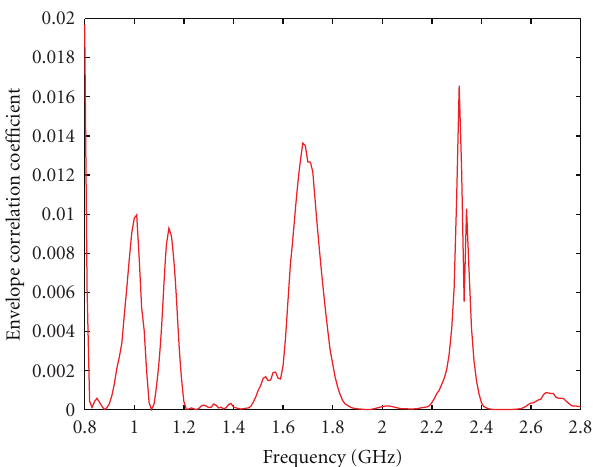
Figure 11: Envelope correlation coe ffi cient computed from the measured S parameters.